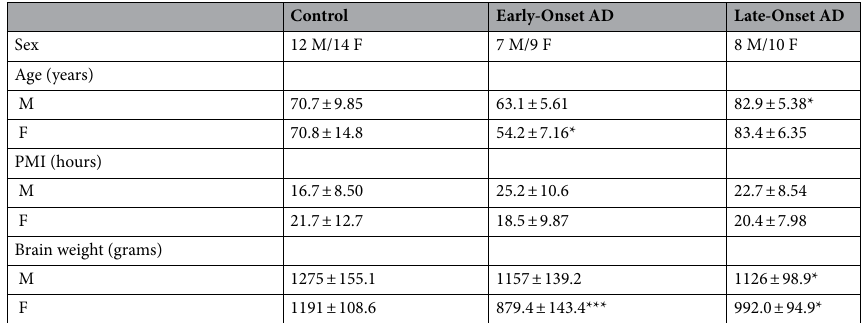
Table 1. Basic donor parameters. The brain samples analyzed for soluble Aβ peptides were obtained from neurologically normal cases (Control) and from histopathologically confirmed cases of Early-Onset or Late- Onset Alzheimer disease (AD). M, male; F, female; years (time-at-death; age at autopsy); PMI, post-mortem interval; * P < 0.05; *** P < 0.001; vs. control donors (mean ±